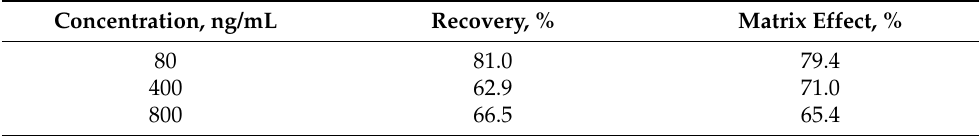
Table 2. Results on the extraction recovery and matrix effect.